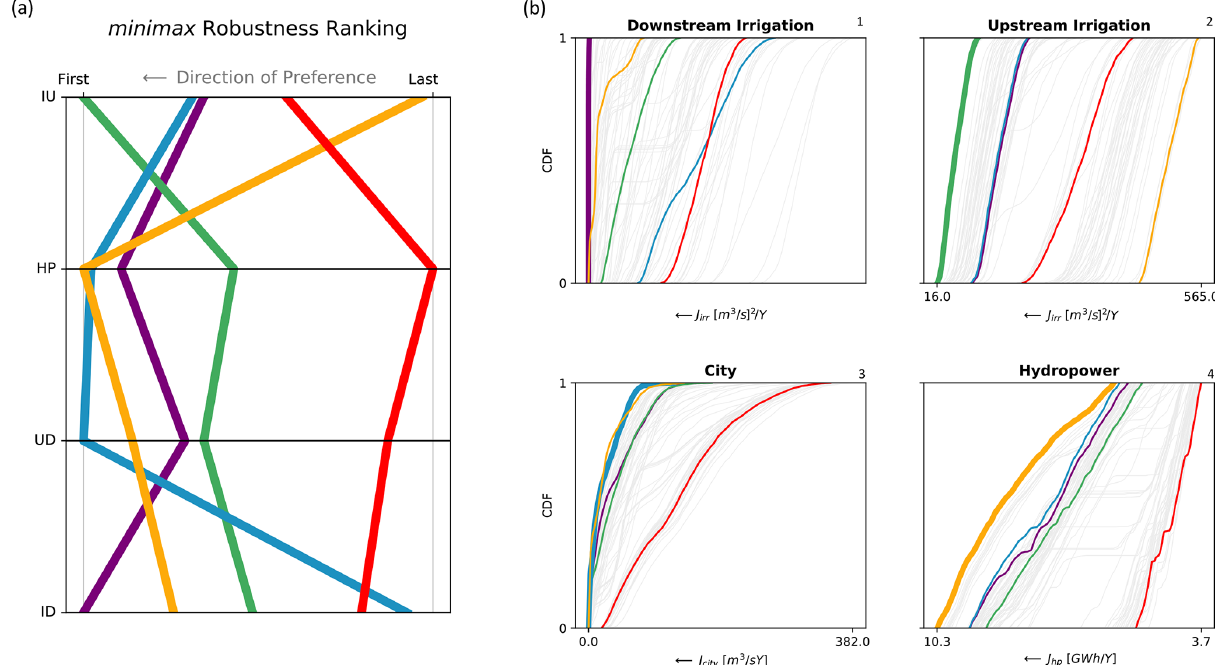
Figure 6. (a) Ranking of the best solution according to each stakeholder, along with where these solutions fall when ranked according to other stakeholders. (b) Cumulative distribution functions for the four objectives, using the most robust alternative for each stakeholder. The red line represent a non-robust